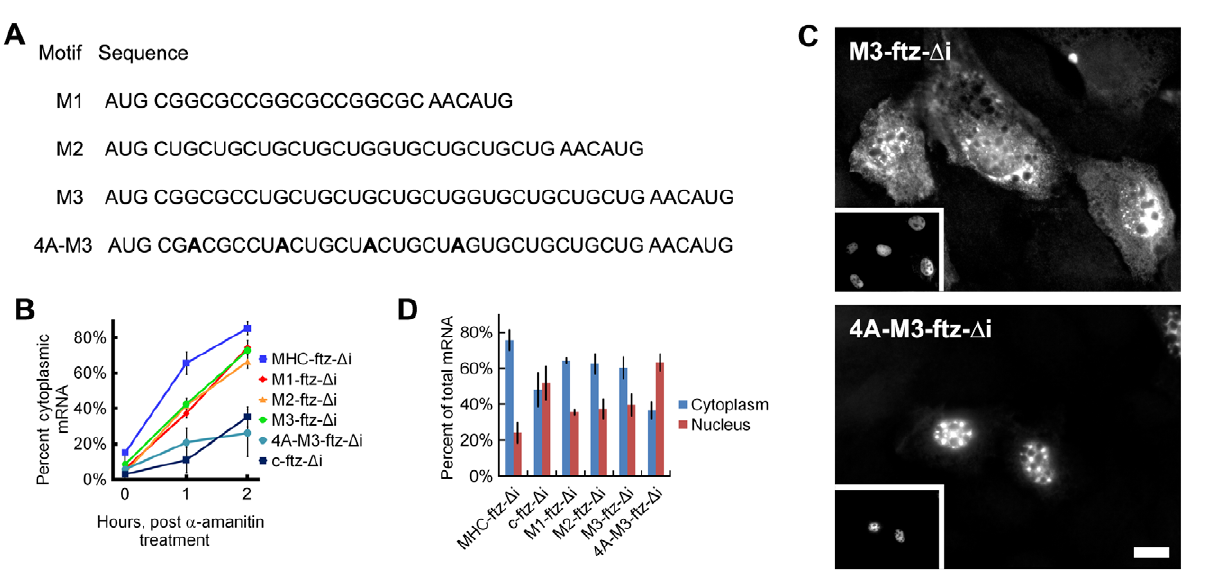
Figure 7. ALREX–associated motifs promote nuclear export of mRNA. Various RNA motifs were inserted just after the start codon of the c-ftz- D i construct. The nucleotide sequences of each RNA insert are depicted in (A). Note that the 4 silent adenine mutations used to convert M3 into 4A-M3 are indicated in bold. (B) DNA plasmids containing various versions of ftz were microinjected along with fluorescent 70 kD dextran into the nuclei of NIH 3T3 fibroblasts. After 20min, a -amanitin was added to halt further transcription and the cells were allowed to export the RNA for the indicated time periods. Cells were fixed, stained for ftz mRNA and export was quantified as in Figure 3B. Each bar represents an average of three separate experiments, each of which consisted of 15–30 cells. Error bars represent the standard deviation of the three experiments. (C) Representative cells from (B) microinjected with DNA plasmids containing either M3-ftz- D i or 4A-M3-ftz- D i and fixed 2 hours after a -amanitin treatment. Cells were imaged for ftz mRNA by FISH and fluorescent 70 kD dextran (insets). Scale Bar=15 m m. (D) COS-7 cells were transfected with plasmids containing various versions of ftz and allowed to express the mRNA overnight. The cells were then fixed and stained for ftz mRNA by FISH and the cytoplasmic over the total fluorescence signal was quantified as in Figure 3B. Each bar represents an average of five separate experiments, each of which consisted of 20–50 cells. Error bars represent the standard error of the mean between the experiments.